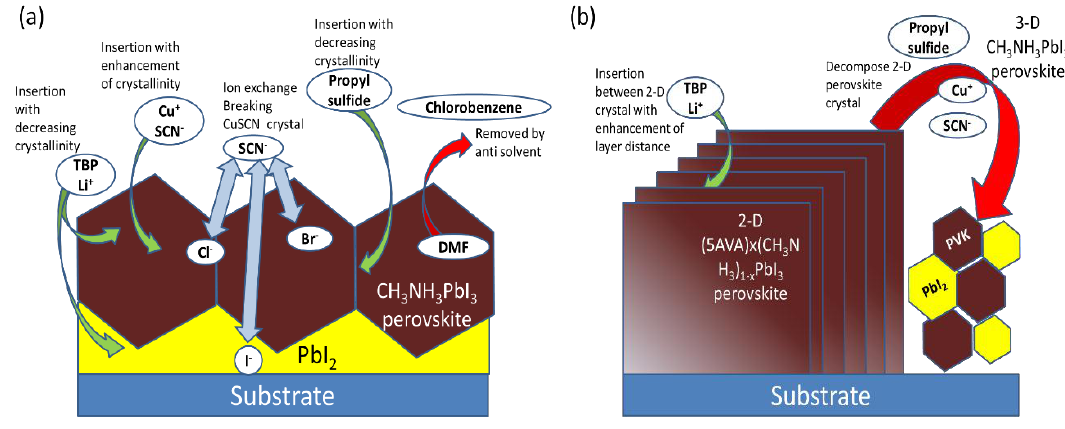
Figure 7. Summary of the reaction scheme of organo lead halide perovskite layers